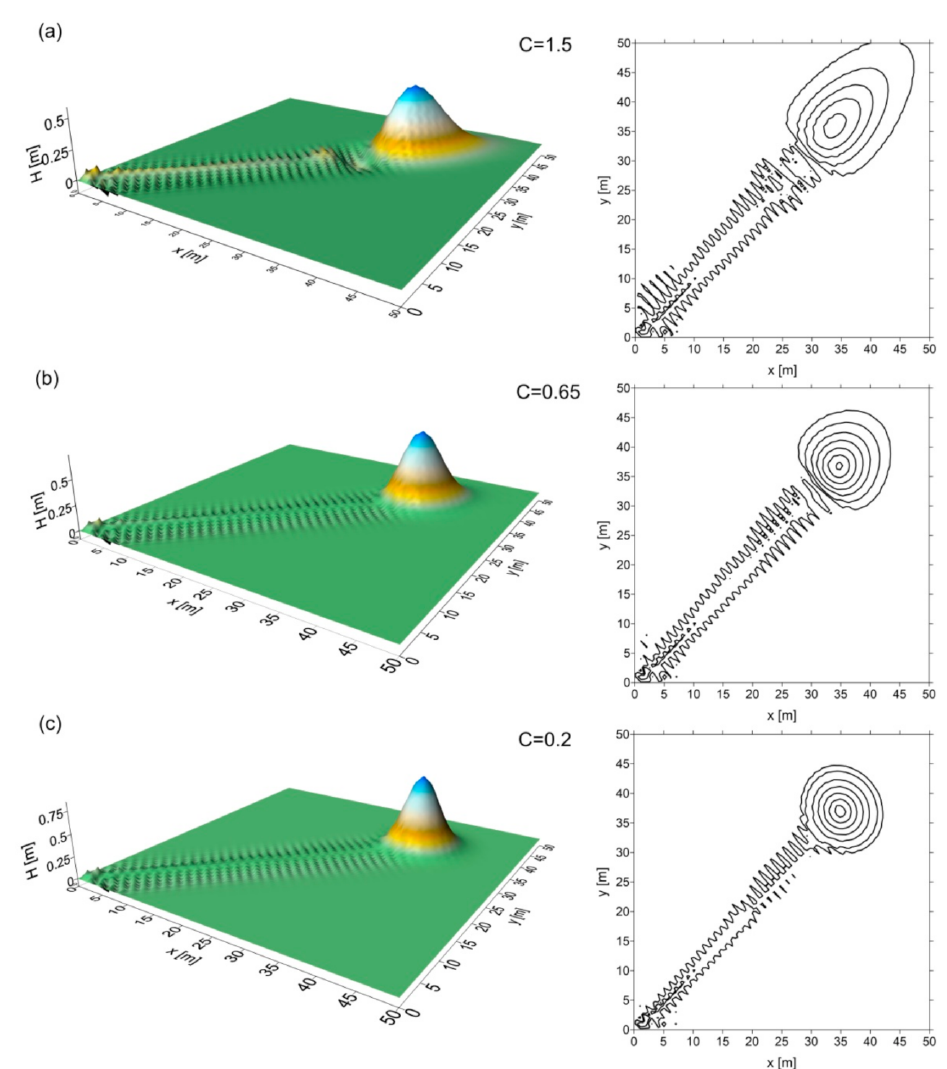
Figure 13. Solution obtained the 8N using mesh with θ = 0.5 and α = 1/2 for various values of the Courant number: ( a ) C = 1.5; ( b ) C = 0.65; ( c ) C =